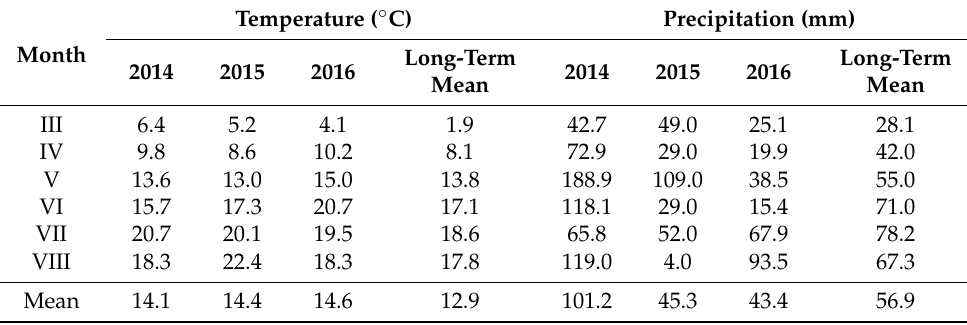
Table 2. Total precipitation and average monthly temperatures in the experiment.